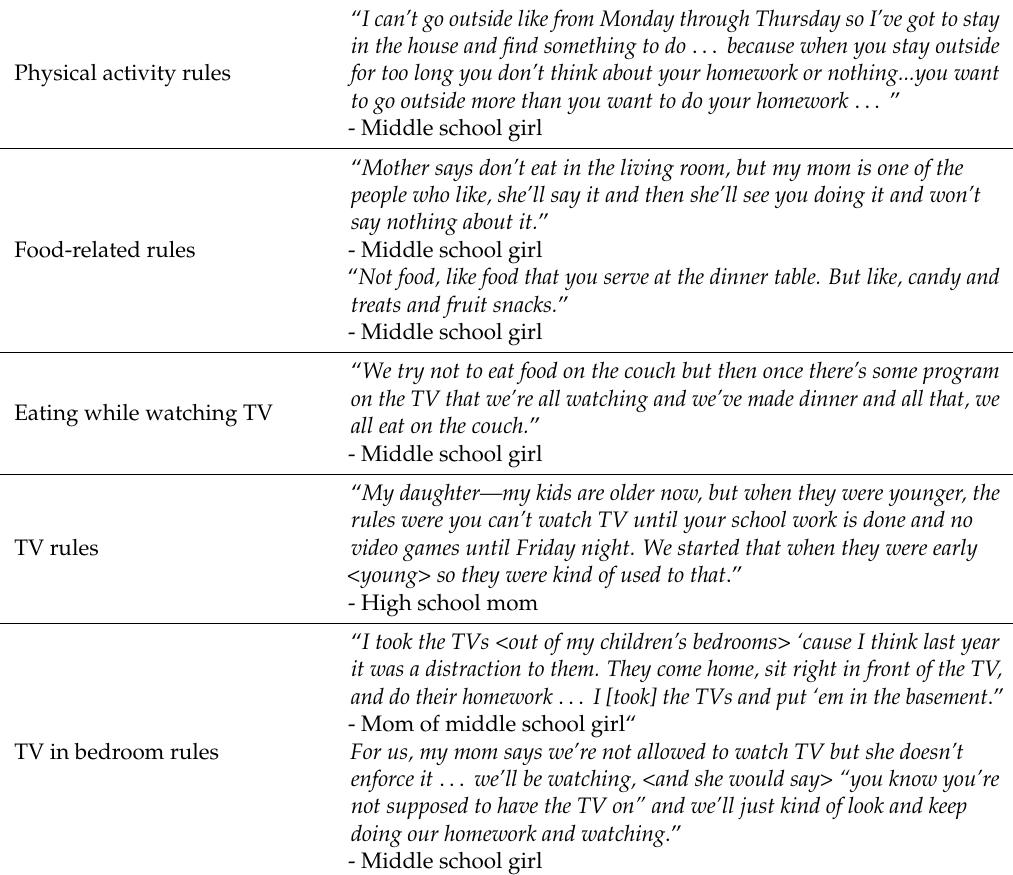
Table 3. Quotes illustrating home rules that influence physical activity and food